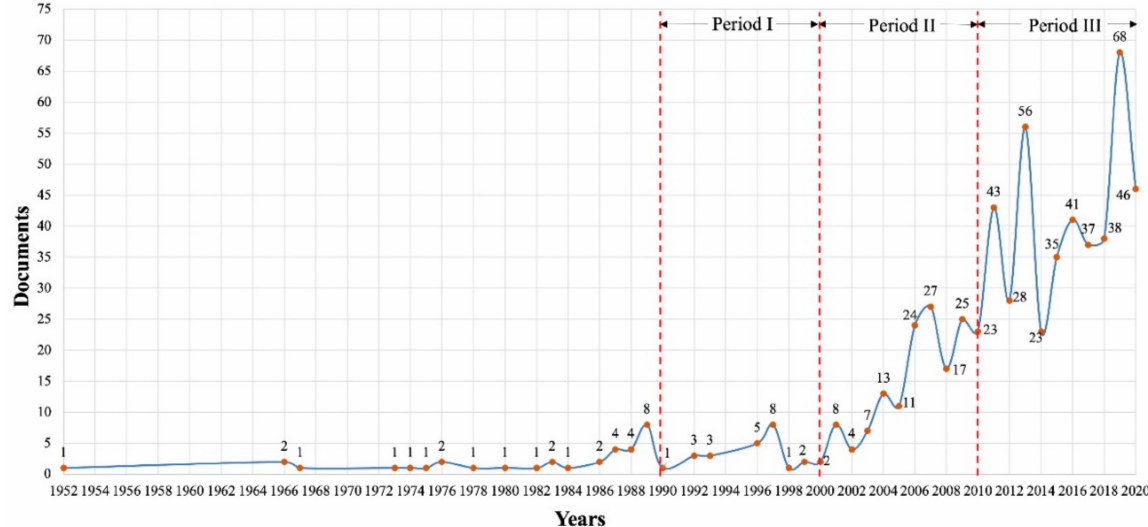
Figure 3. Growth of scientific production of